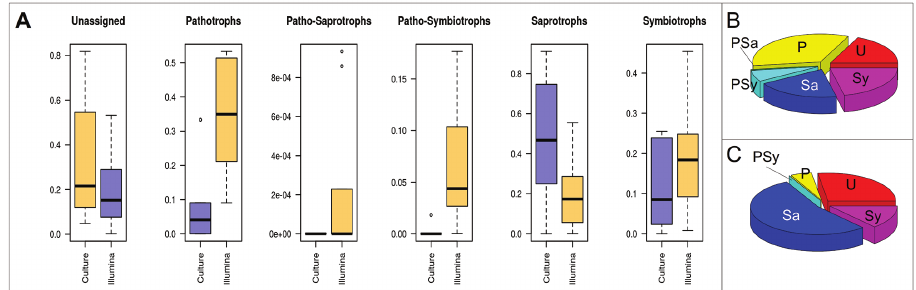
Figure 4. Relative abundance of fungal leaf-inhabiting endophytes of beech among the five main trophic guilds as revealed by analysis with FUNGuild (Nguyen et al. 2016). A compares the two methods for each trophic guild and unassigned data. B displays the trophic guilds and unassigned taxa for Illumina data, C for cultivation data. Abbreviations in [ B and C ]: U = Unassigned, P = Pathotrophs, PSa = Patho-